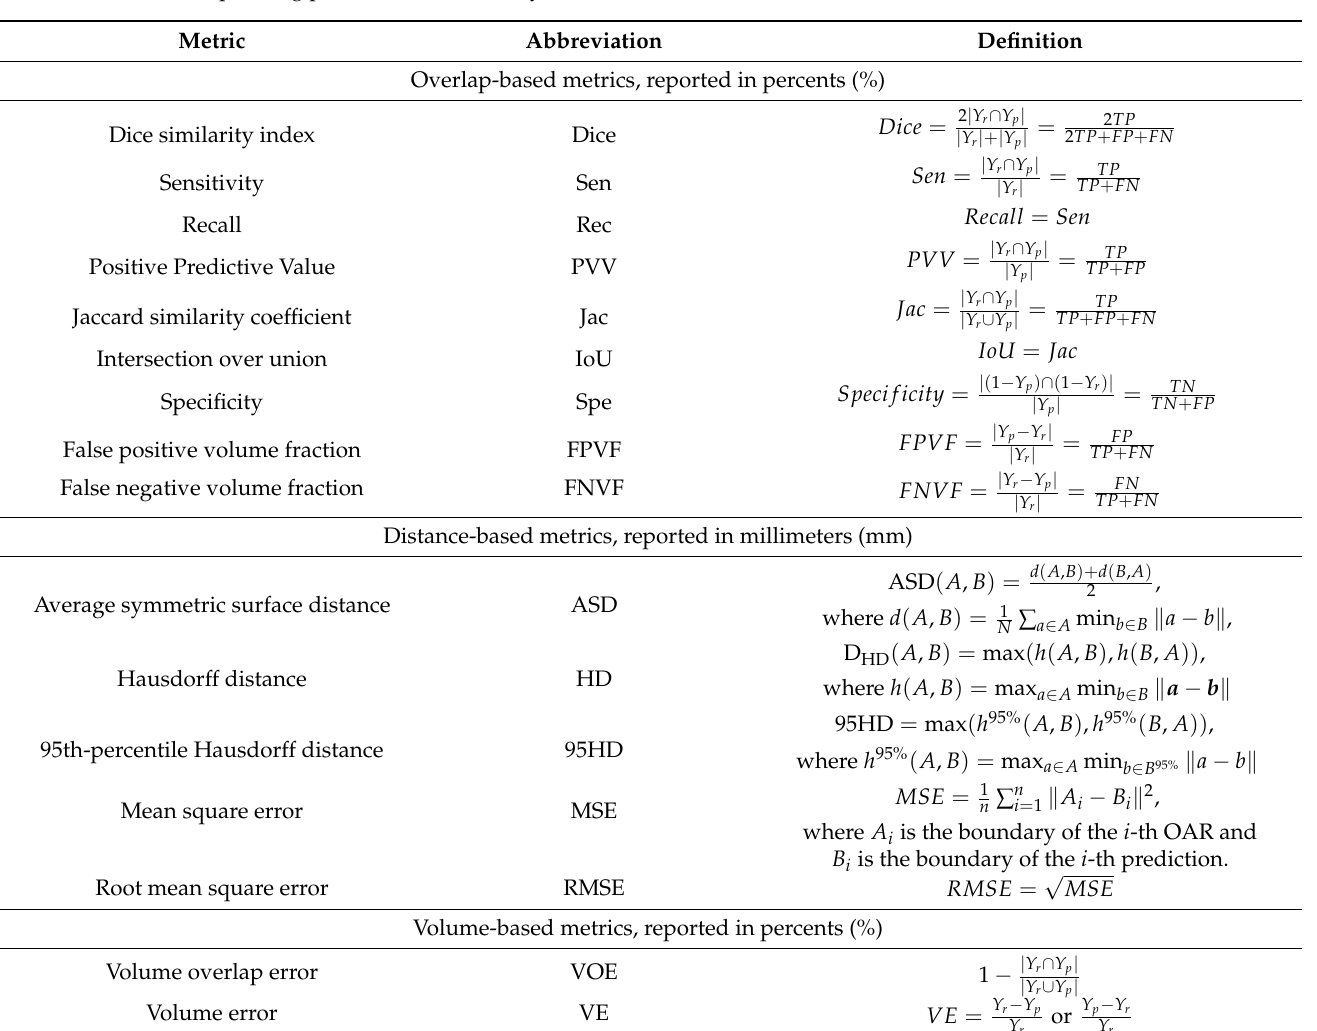
Table 1. Performance metrics applied to performance measurement of automatic segmentation of the mandible and the corresponding references and mathematical definitions. Note: Y r indicates the pixels in the reference standard (ground truth), and Y p is the pixels in the automatic segmentation. | . | represents the number of voxels. (cid:107) . (cid:107) represents the L 2 norm. a and b are corresponding points on the boundary of A and B .